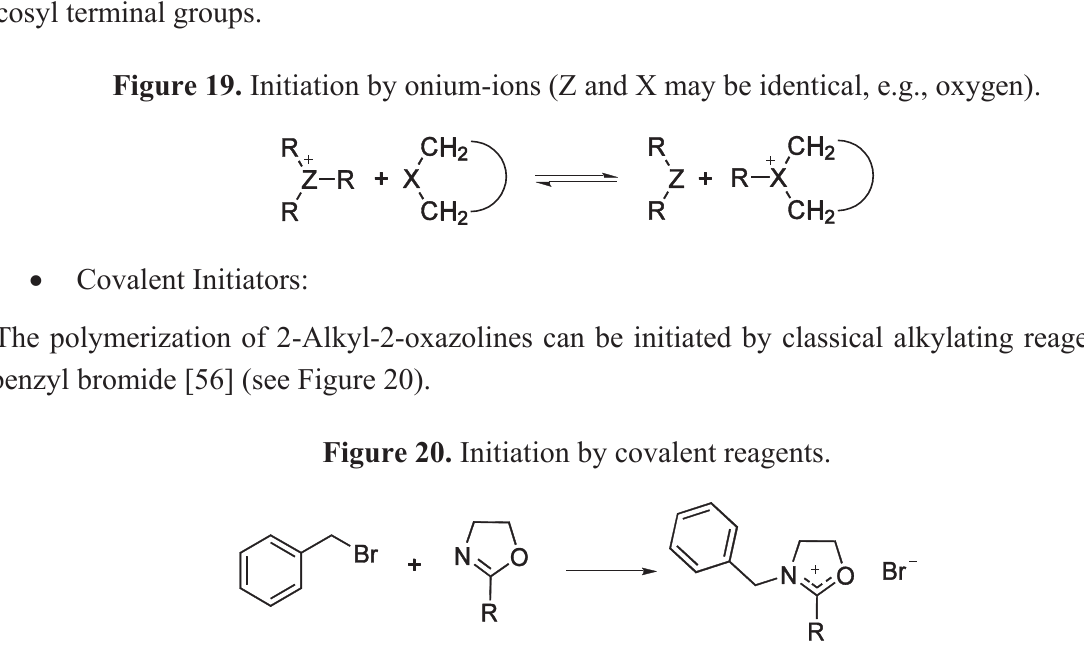
Figure 21. Initiation of the CROP of THF by PF